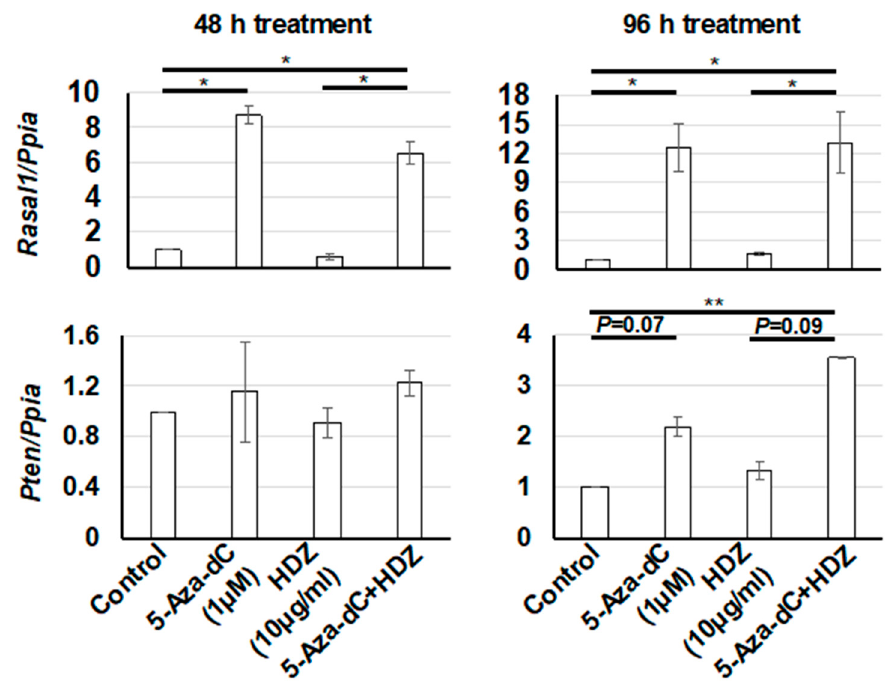
Figure 3. mRNA expression levels of Rasal1 and Pten , which are antifibrotic genes, in HSC-T6 cells treated with 5-aza-dC, HDZ, and 5-aza-dC and HDZ combined. The mRNA expression levels were measured by semi-quantitative RT–PCR. The effects of 5-aza-dC, HDZ, and combined treatment with 5-aza-dC and HDZ were compared with untreated control cells. Data are the mean ± SD (n = 3). * p < 0.05 and ** p < 0.01 vs. the untreated control.